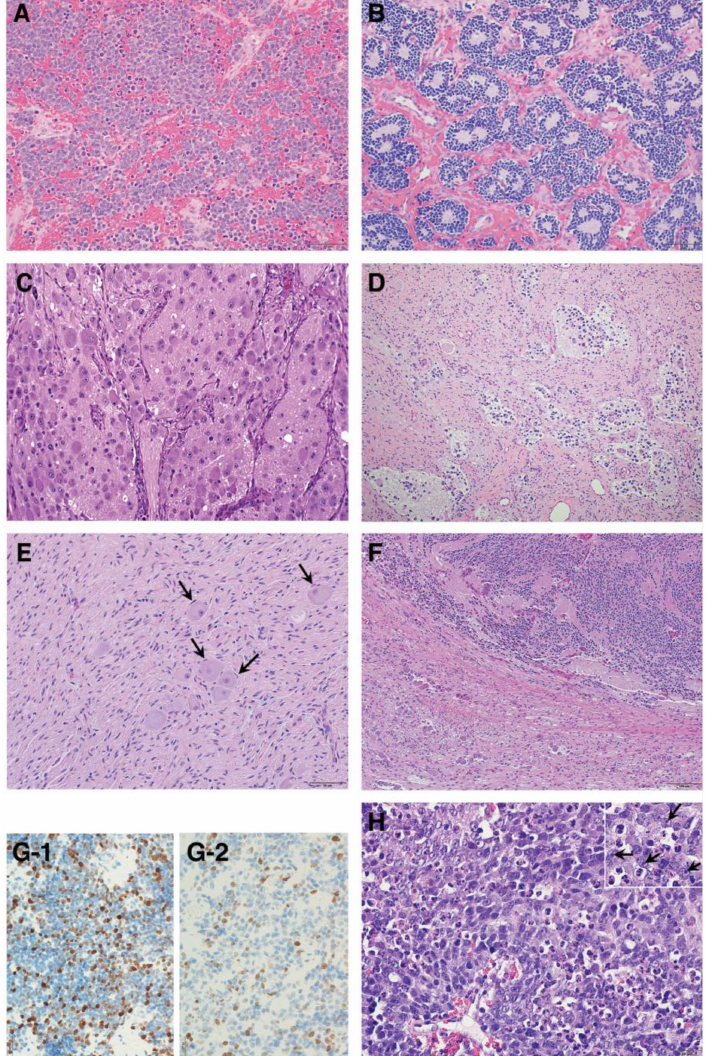
Figure 3. Histologic features of peripheral neuroblastic tumors: ( A ) neuroblastoma (Schwannian stroma-poor), undifferentiated subtype (original, × 200); ( B ) neuroblastoma (Schwannian stroma- poor), poorly differentiated subtype (original, × 200); ( C ) neuroblastoma (Schwannian